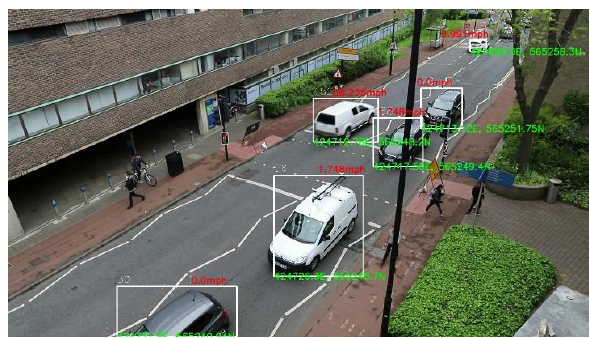
Figure 5. Results imposed on DSLR camera footage to display bounding box detections (white), automatically assigned vehicle tracking numbers (white), travel traces (with corresponding real-world coordinates) (green), and speed estimation results (red).